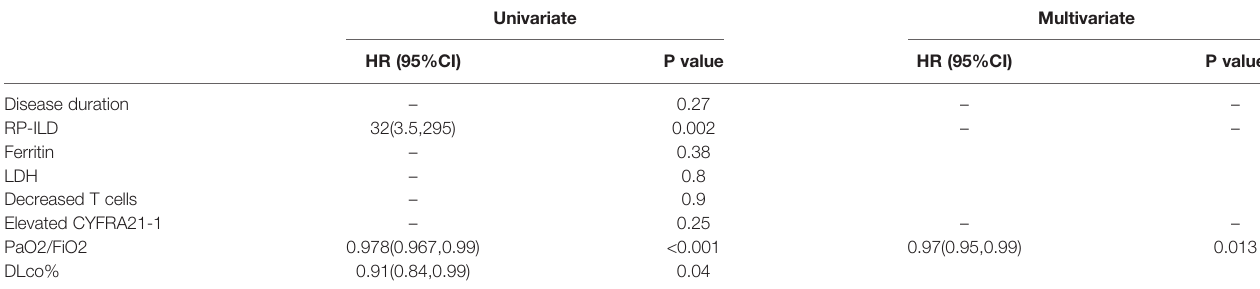
(Table 5 Breakdown), RPILD, rapidly progressive interstitial lung disease; LDH, Lactate Dehydrogenase; DLco, diffusing capacity for carbon